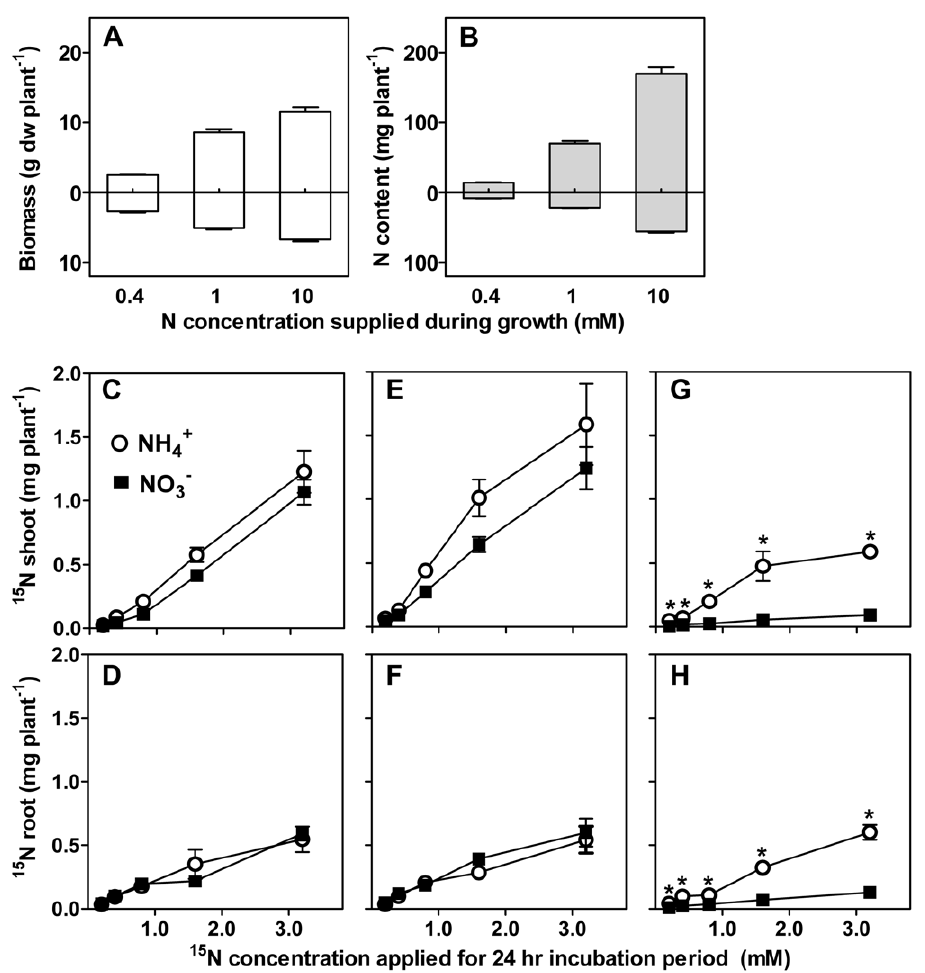
Figure 2. Nitrate and ammonium uptake with increasing N supply. Dry biomass ( A ) and total plant N content ( B ) for shoots and roots of sugarcane plants used for 15 N labelling experiment with increasing N supply rates. Nitrogen treatments correspond to low (0.4 mM), intermediate (1 mM) and high (10 mM) N supply. Bars represent mean 6 standard error (n=20). Data from three commercial sugarcane varieties were pooled. Uptake of 15 N into shoots (C, E , G ) and roots ( D , F , H ) of plants grown at low (0.4 mM N) ( C, D ), intermediate (1 mM N) ( E, F ) and high (10 mM N) ( G, H ) N supply. 15 N was supplied to plants as either 15 NH 4 NO 3 ( # ) or NH 415 NO 3 ( & ) at concentrations from 0.2 to 3.2 mM 15 N for 24 h. Data represent mean 6 standard error (n=3). * indicate significance difference between NH 4 and NO 3 uptake at P , 0.05 (ANOVA on ln transformed data, Tukey’s post hoc test).